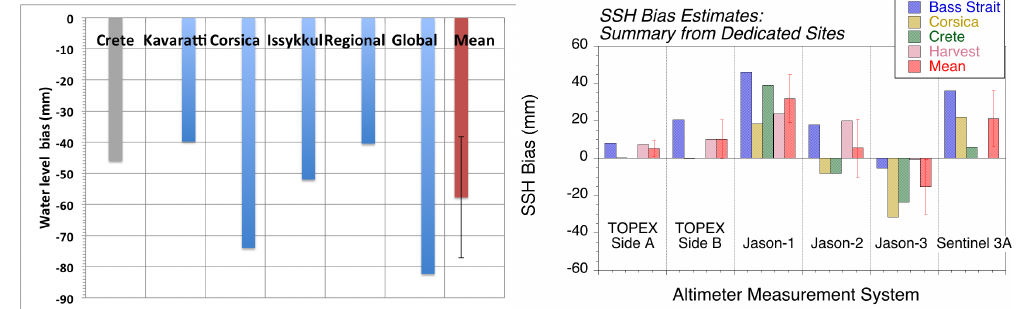
Figure 2. Left (this study): water level bias from Crete [8], Kavaratti (Section 2.1.1), Corsica (Section 2.1.2, Lake Issykul (Section 2.1.3), the regional (Section 2.2) and global (Section 2.3) approaches. The mean value of all the determinations is − 54 mm with a standard deviation of 15 mm. Right [9]: TOPEX, Jason and Sentinel-3A Sea Surface Height (SSH) biases from in situ calibration sites. 2.1. Water Level Calibration from Open-Ocean, Coastal and Inland Waters In Situ Absolute Calibration